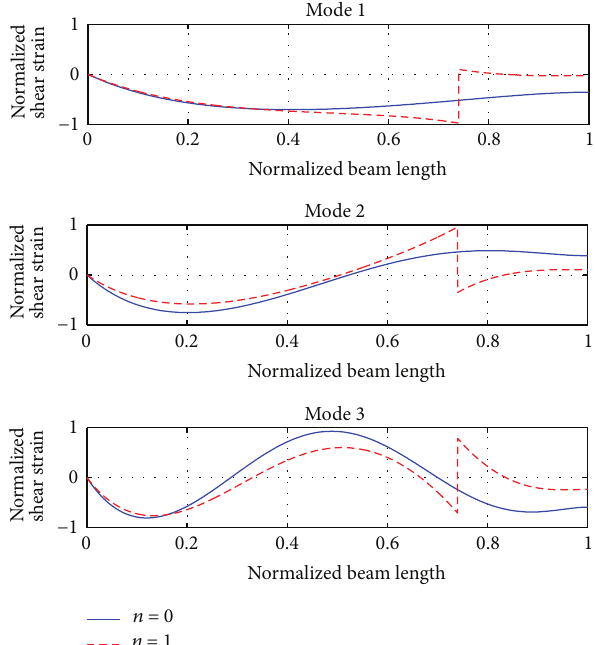
Figure 11: Comparison of the shear strain field between full-cover and segmented CLD beams with ratio 𝐻 𝑏 = 𝐻 𝑐 = 0.012 .